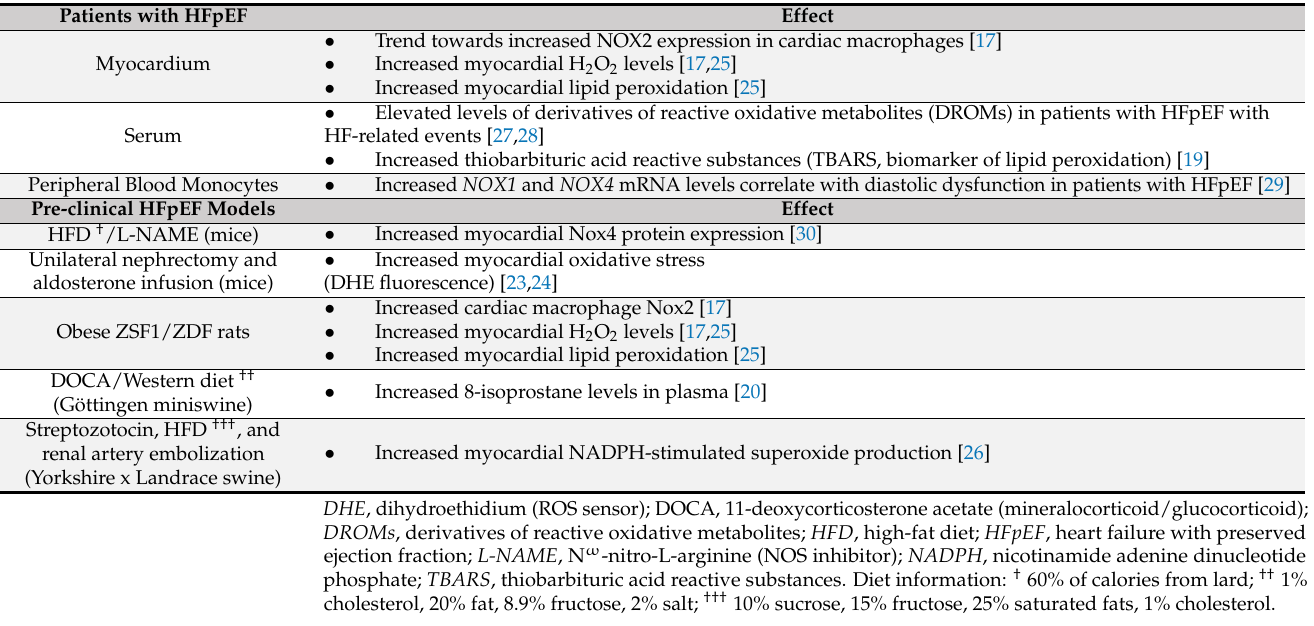
Table 1. Reported evidence of oxidative stress and dysregulation of NOX enzymes in patients and animal models with